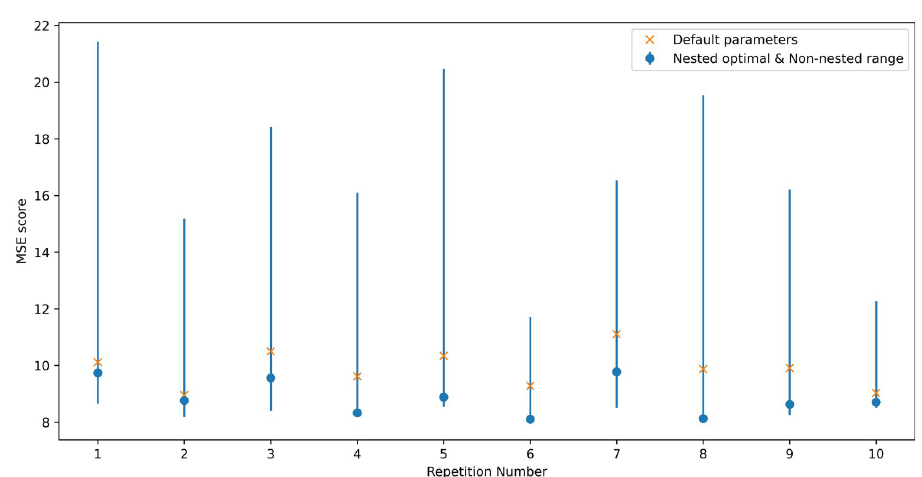
Fig 5. Performance (as quantified by the MSE in each of the 10 splits to folds) of the default set of parameter values used in the random forest (yellow x) compared to the optimal parameters for the random forest identified through nested optimisation (blue circle). Blue lines are the MSE minimum to maximum range for the 96 points of the parameters grid (hence this minimum is the optimal result of the non-nested optimization method).